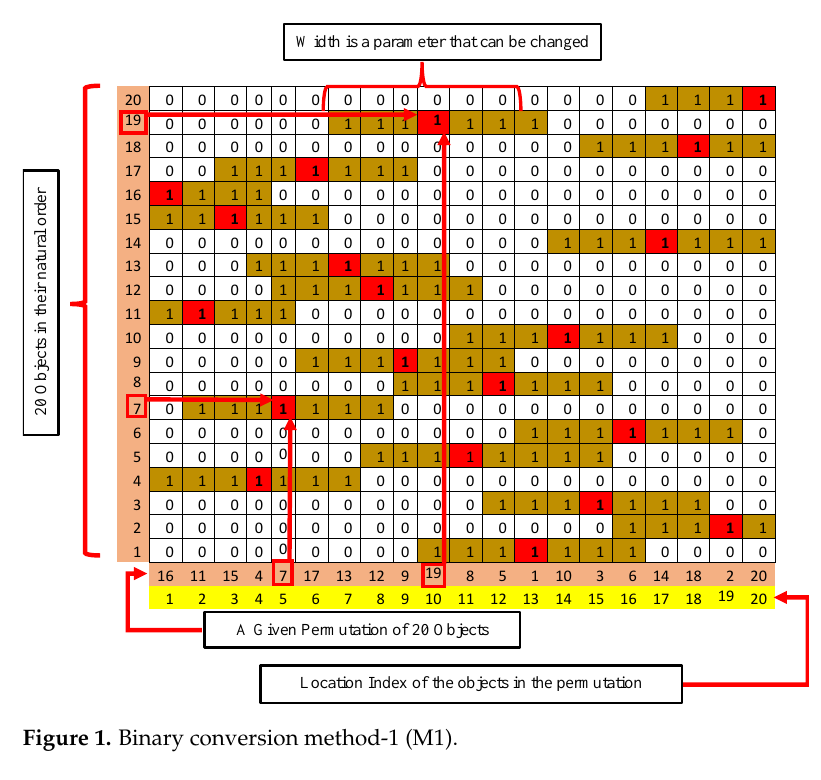
Figure 1. Binary conversion method-1 (M1).